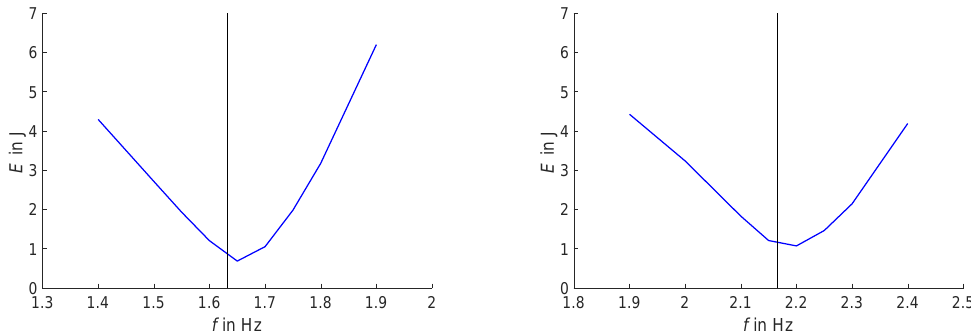
Figure 11. Energy-frequency behavior (blue) for sinusoidal trajectories at 75Nmrad − 1 ( left ) and 150Nmrad − 1 ( right ); antiresonance (black) at 1.63Hz ( left ) and 2.17Hz,